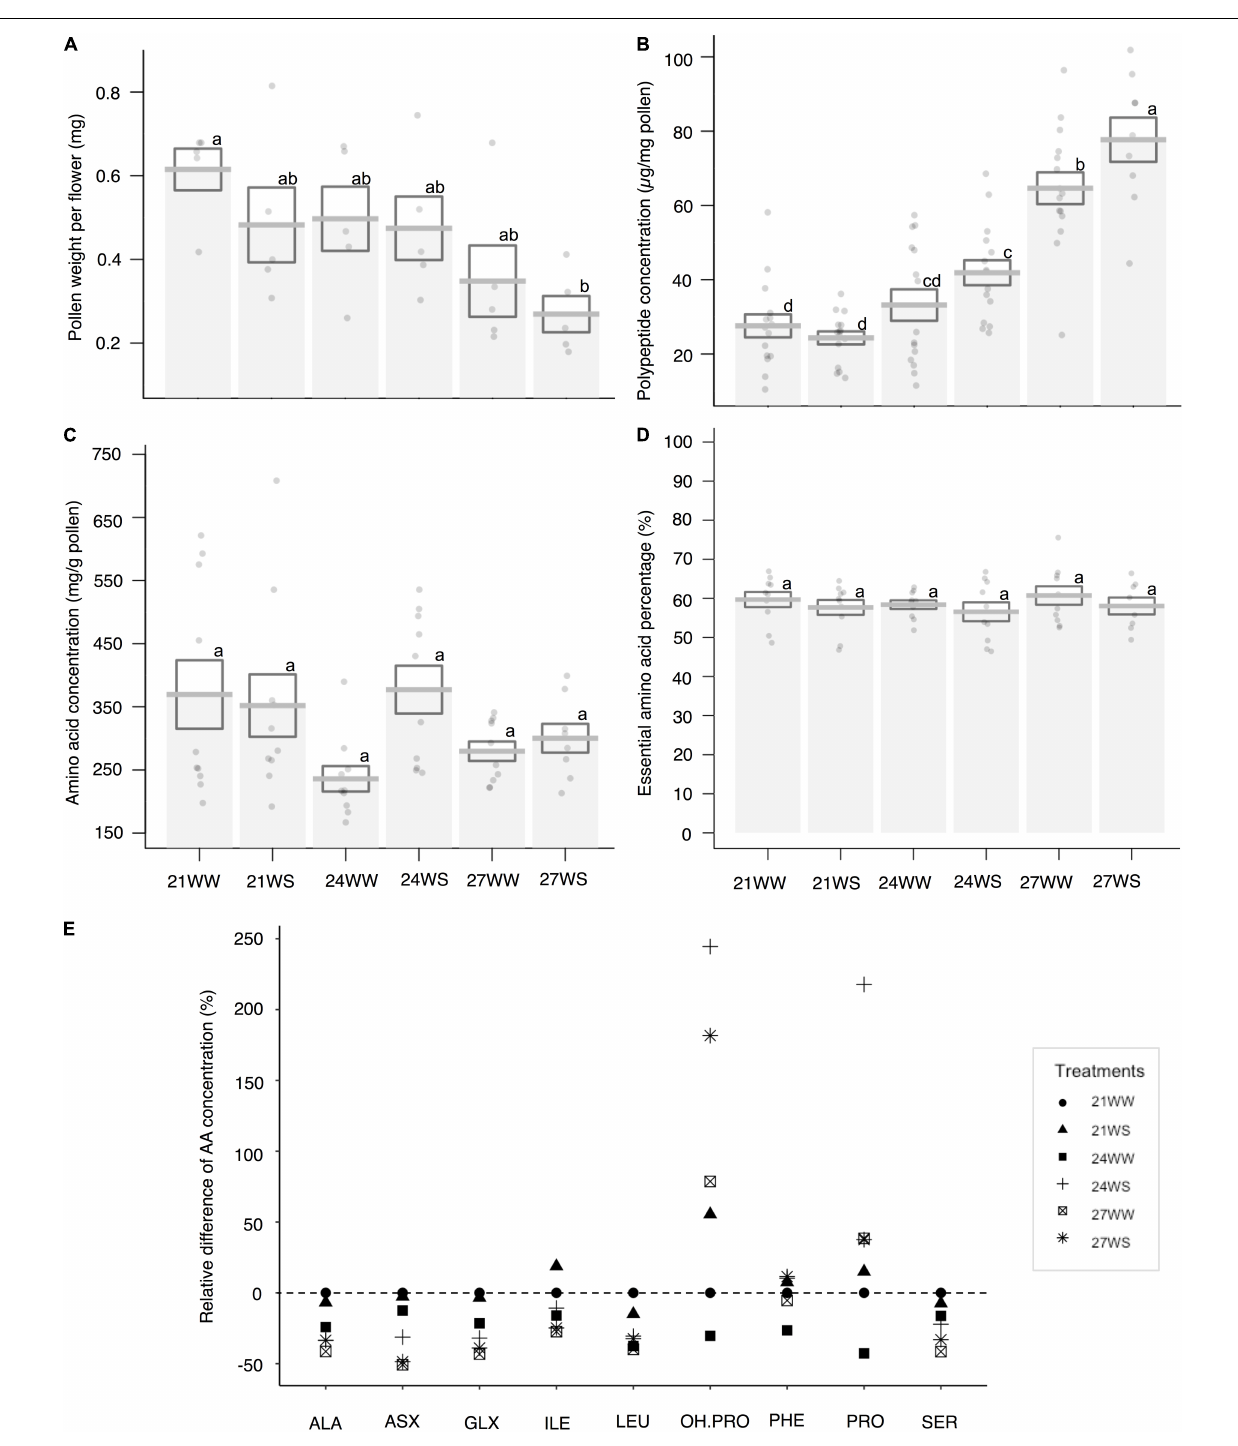
FIGURE 4 | Effects of temperature rise and water stress on pollen quantity and composition of B . officinalis , 3 weeks after stress induction: (A) pollen weight per flower (mg); (B) total polypeptide concentration ( µ g/mg pollen); (C) total nectar amino acid concentration (ng/mg nectar); (D) essential amino acid percentage compared to total concentrations (%); (E) relative difference of amino acid concentrations (%). (A,B) N = 5 plants, (C–E) N = 3 plants. (A–D) Data are mean ± SE; data points followed by different letters for the same parameter are significantly different at P < 0.05 among treatments; (E) data are mean and relative values compared with 21WW. 21, 21 ◦ C; 24, 24 ◦ C; and 27, 27 ◦ C; WW, well-watered; WS, water-stressed. Only significant changes in amino acid concentrations are shown: ALA, alanine; ASX, asparagine + aspartic acid; GLX, glutamine + glutamic acid; ILE, isoleucine; LEU, leucine; OH.PRO, hydroxyproline; PHE, phenylalanine; PRO, proline; SER,